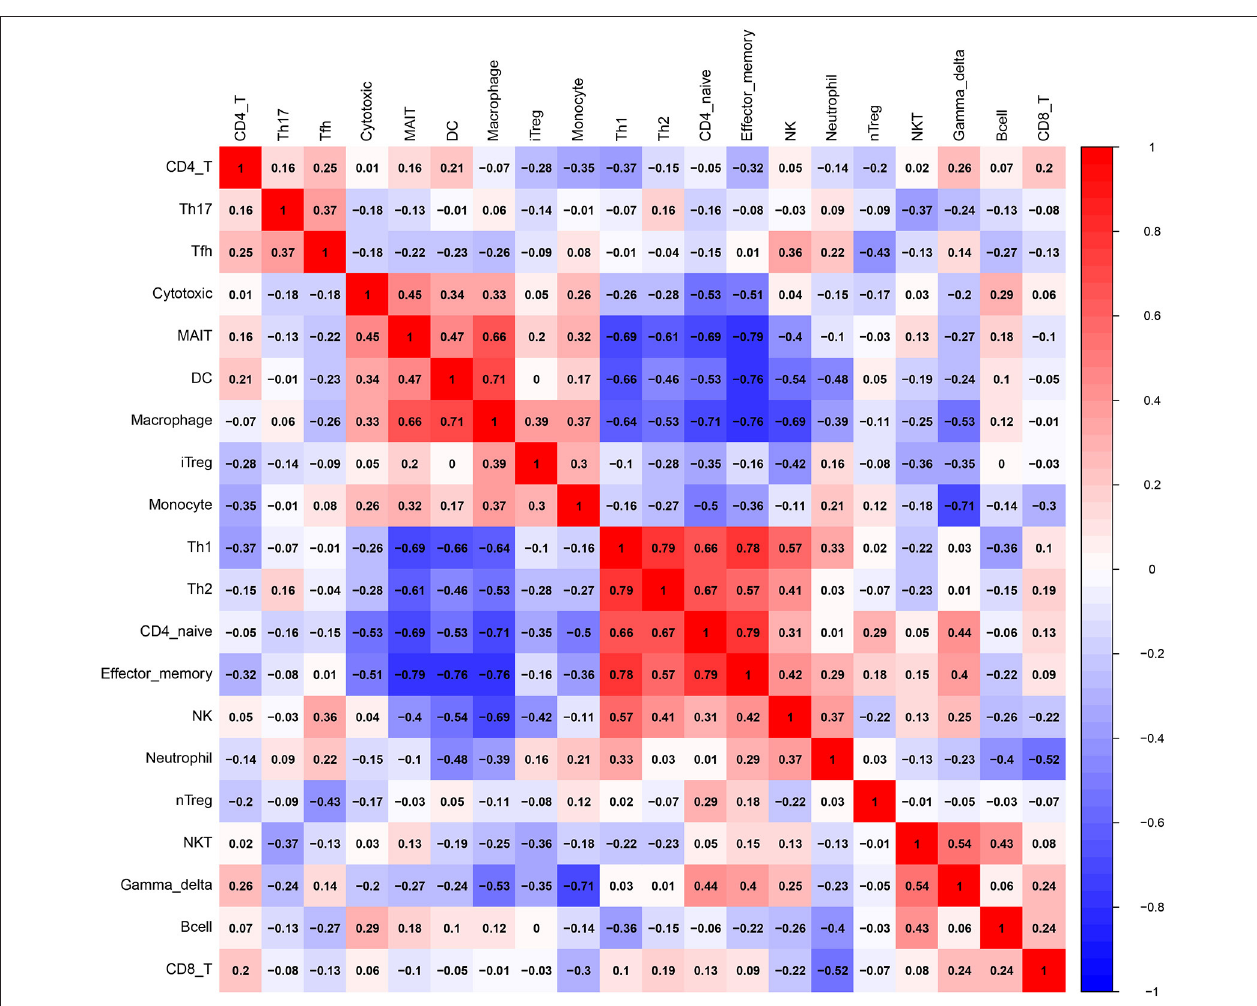
FIGURE 3 | A correlation matrix of immune cell proportions between normal and atherosclerotic tissues.